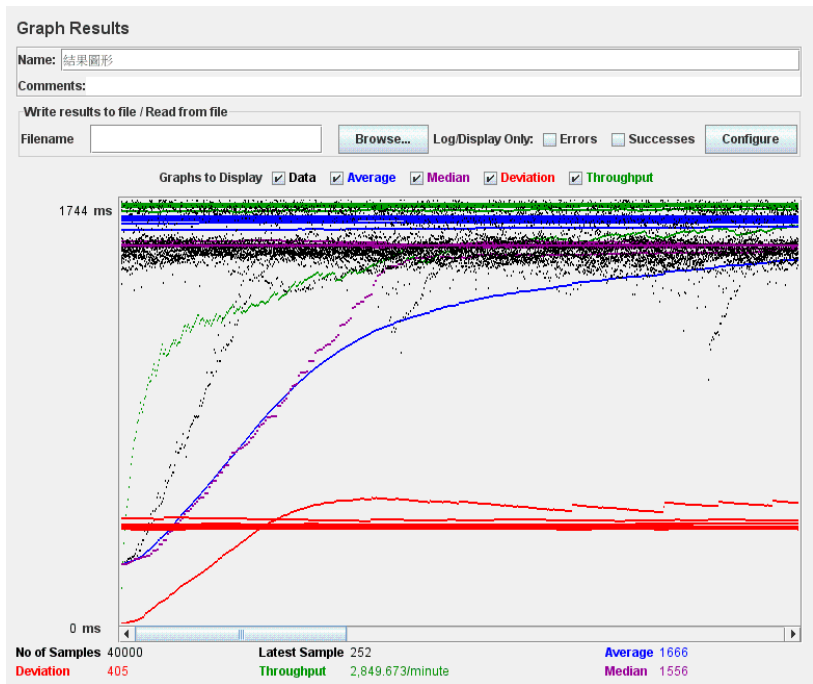
Figure 16 . HA-server load balancing